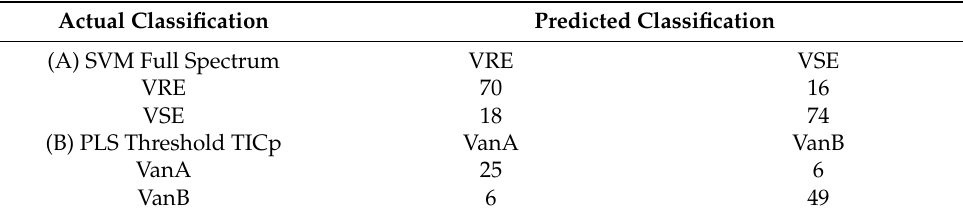
Table 3. Discrimination of vancomycin-susceptible E. faecium (VSE) from vancomycin-resistant E. faecium (VRE) isolates and, within the latter group, differentiation between the strains hosting the vanA and vanB resistance genes. The actual classification is shown in columns and the predictive classification in rows. ( A ) Results from the support vector machine (SVM) algorithm using the full-spectrum-TIC method. Accuracy: 80.9%; F1 score: 80.46%; sensitivity: 81.4% specificity: